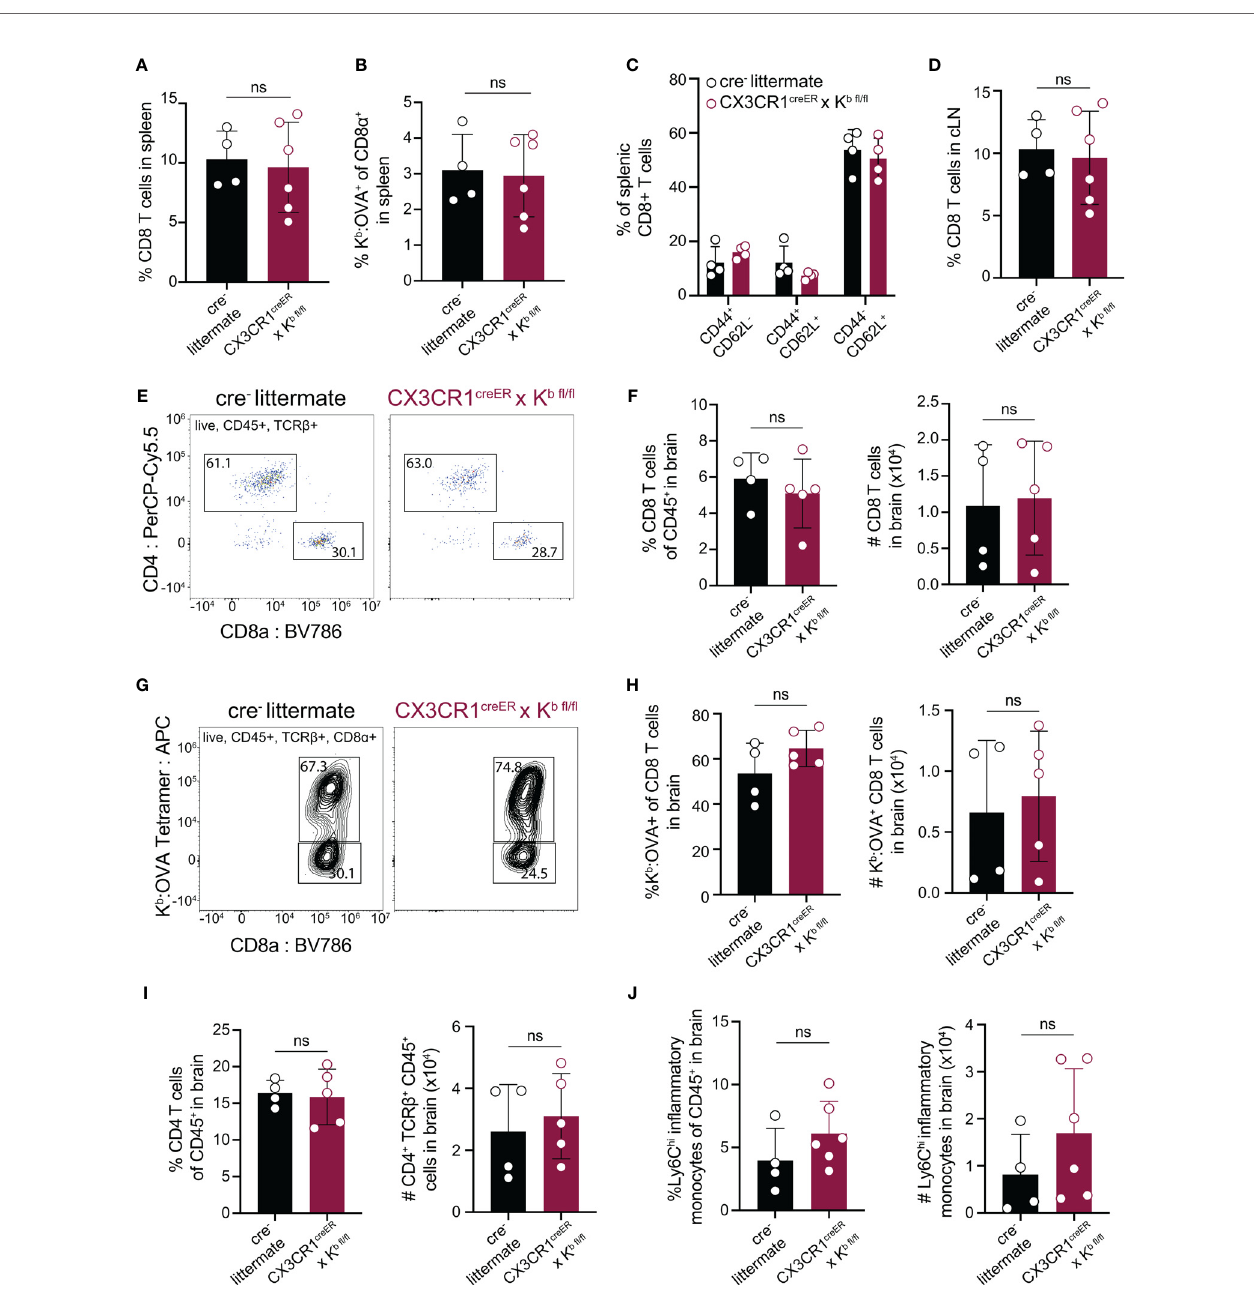
FIGURE 4 | Deletion of H-2K b in CNS-myeloid cells does not impact CD8 T cell responses to the K b restricted antigen OVA 257-264 during CNS-viral infection. Experimental strategy is identical to Figure 3A , in which tamoxifen administration in CX3CR1 cre /K b mice and cre - controls is followed by a 6-week reconstitution period before intracranial (i.c.) infection with TMEV-OVA 257-264 . Spleens, lymph nodes, and brains were isolated and analyzed by fl ow cytometry at 7 days post infection to assess antiviral responses. (A, B) Quanti fi cation of CD8 + T cells (A) and K b : OVA 257-264+ CD8 T cells (B) in the spleens of infected mice. (C) Proportion of naïve (CD44 - CD62L + ), effector (CD44 + CD62L - ), and central memory (CD44 + CD62L + ) CD8 T cells in the spleens of infected mice. (D) Quanti fi cation of CD8 + T cells in the CNS-draining deep cervical lymph node (dCLN) of infected animals. (E) Representative fl ow cytometry plots, and (F) quanti fi cation of total CD8 T cells in fi ltrating the brain at 7 days post infection in CX3CR1 cre /K b mice compared to controls. (G) Representative fl ow cytometry plots, and (H) quanti fi cation of total K b : OVA + CD8 T cells in fi ltrating the brain at 7 days post infection. (I) Quanti fi cation of CD4 T cells recovered from the brains of cre - and CX3CR1 cre /K b mice during infection. (J) In fl ammatory monocytes recovered from the brains of infected cre - and CX3CR1 cre /K b mice are quanti fi ed. Data are shown as individual mice with mean from one independent experiment (n=3-6) of ≥ 3 experimental replicates. Error bars represent standard deviation. Two tailed Welch ’ s t test was used to assess statistical signi fi cance with ns p ≥